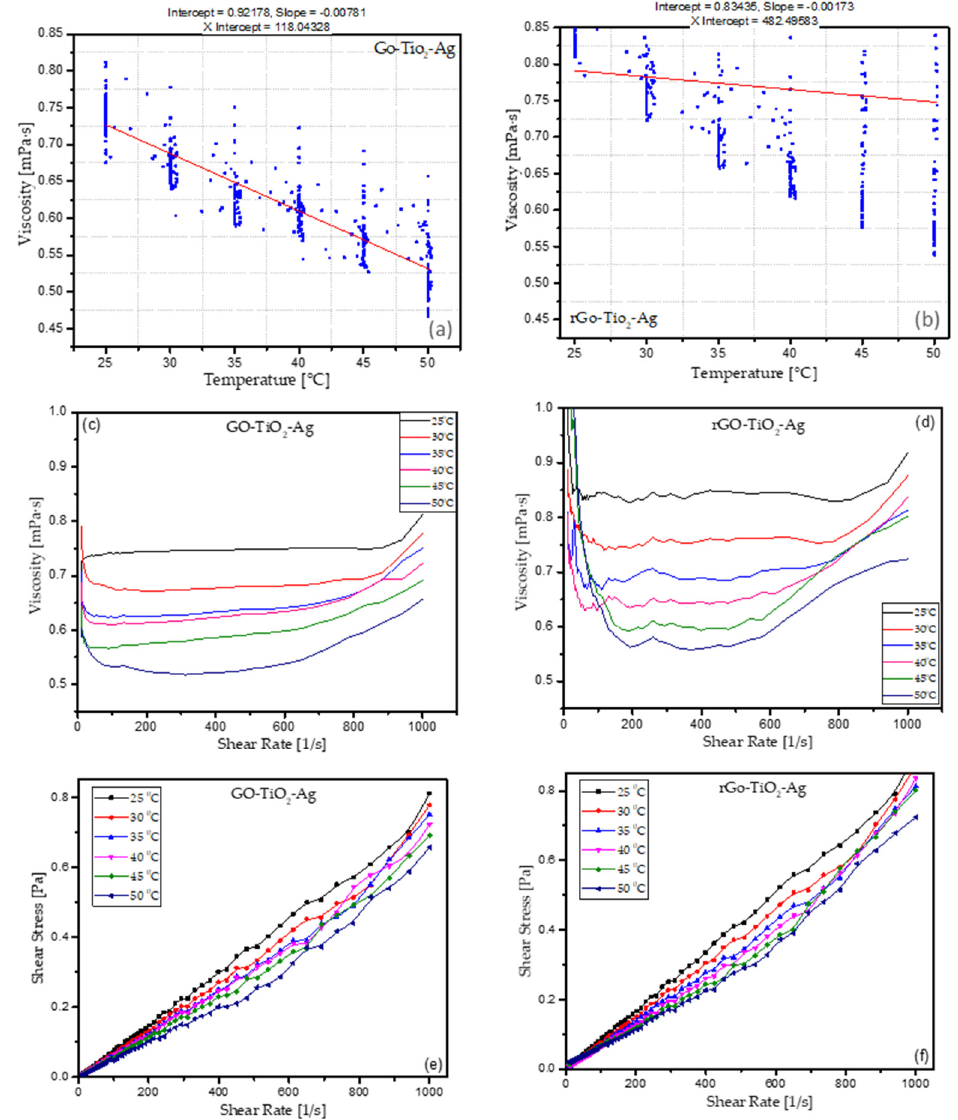
Figure 6. ( a ) Viscosity of THNp GO-TiO 2 -Ag, ( b ) viscosity of THNp rGO-TiO 2 -Ag, ( c ) viscosity vs. the shear rate of THNp GO-TiO 2 -Ag, ( d ) viscosity vs. the shear rate of THNp rGO-TiO 2 -Ag, ( e ) shear stress vs. the shear rate of THNp GO-TiO 2 -Ag, and ( f ) shear stress vs. the shear rate of THNp rGO-TiO 2 -Ag.